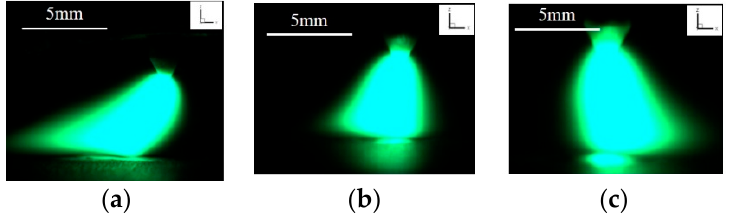
Figure 20. The captured arc images: ( a ) by camera 2, ( b ) by camera 1, and ( c ) by camera 1.